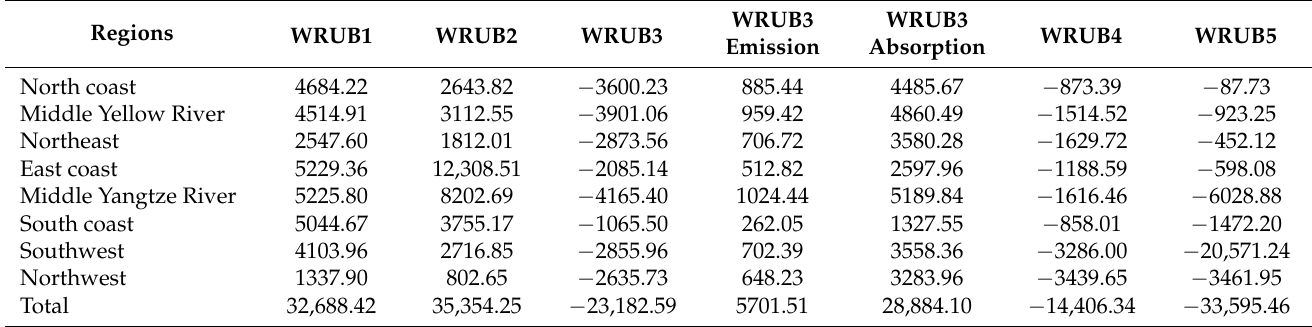
Table 6. CEE of WRUBs in eight regions of China in 2020 (10,000